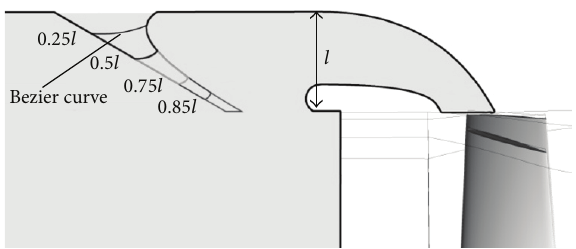
Figure 13: The geometry of different noise baffle